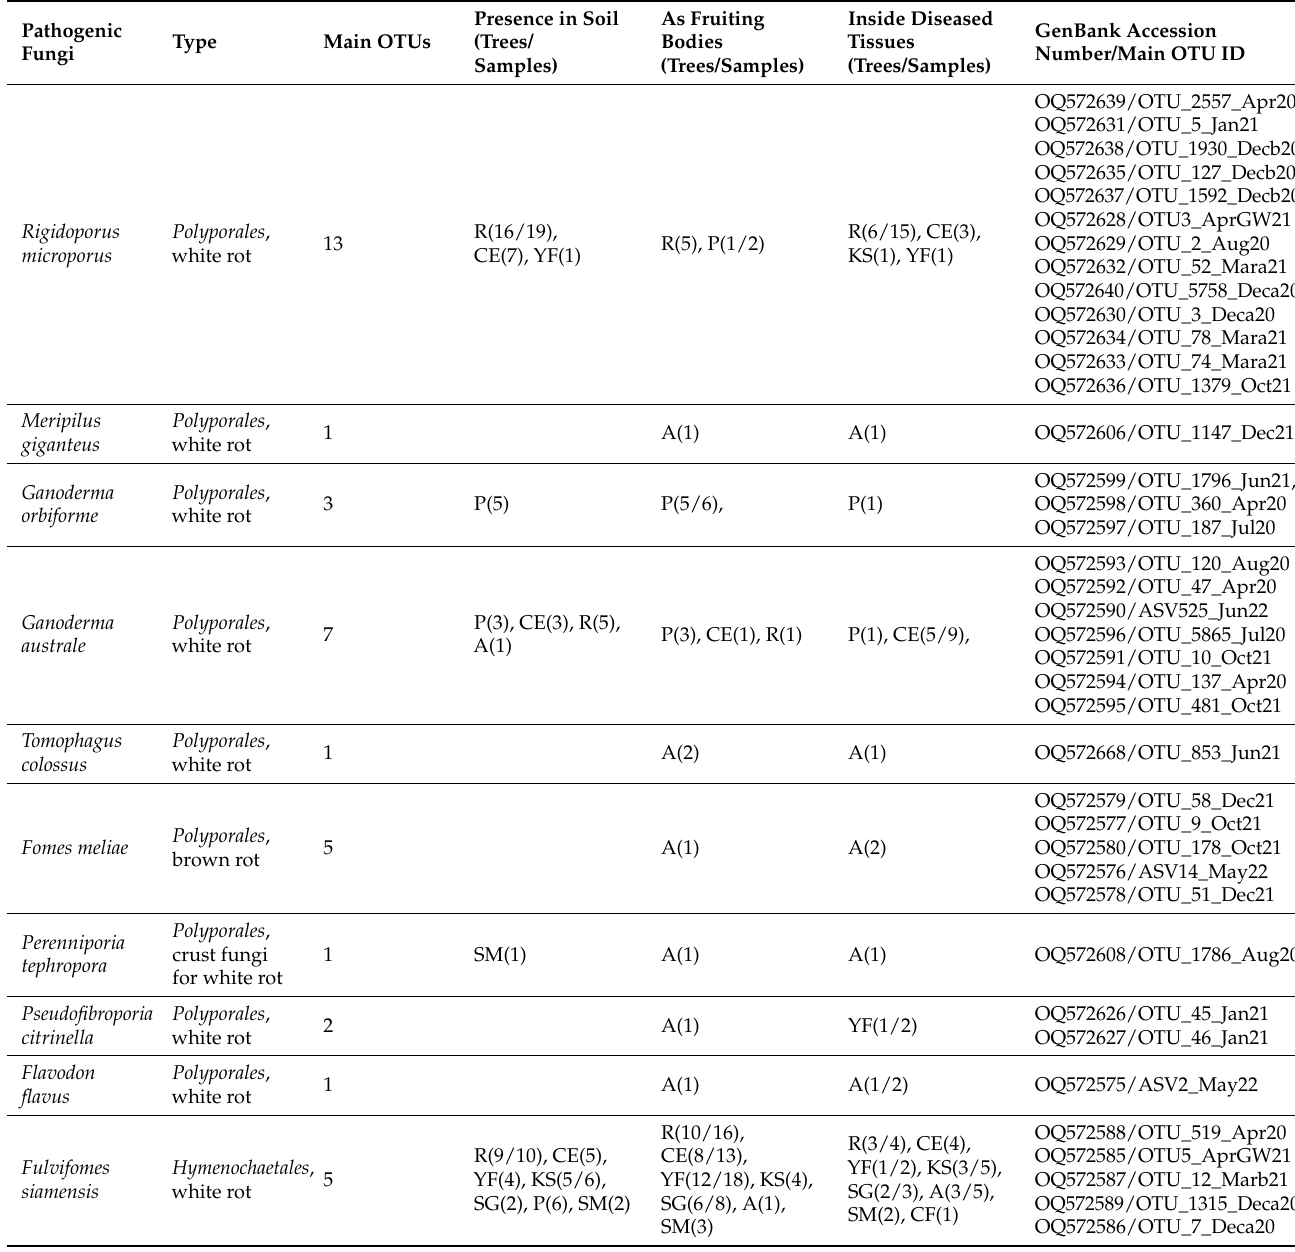
Table 3. The short list of wood decay fungi for Singapore urban trees. The presence of each fungus in the soil, as the fruiting body and inside diseased tissues is represented by tree codes followed by the number of trees and total number of samples in brackets. GenBank accession numbers for the main OTUs are also